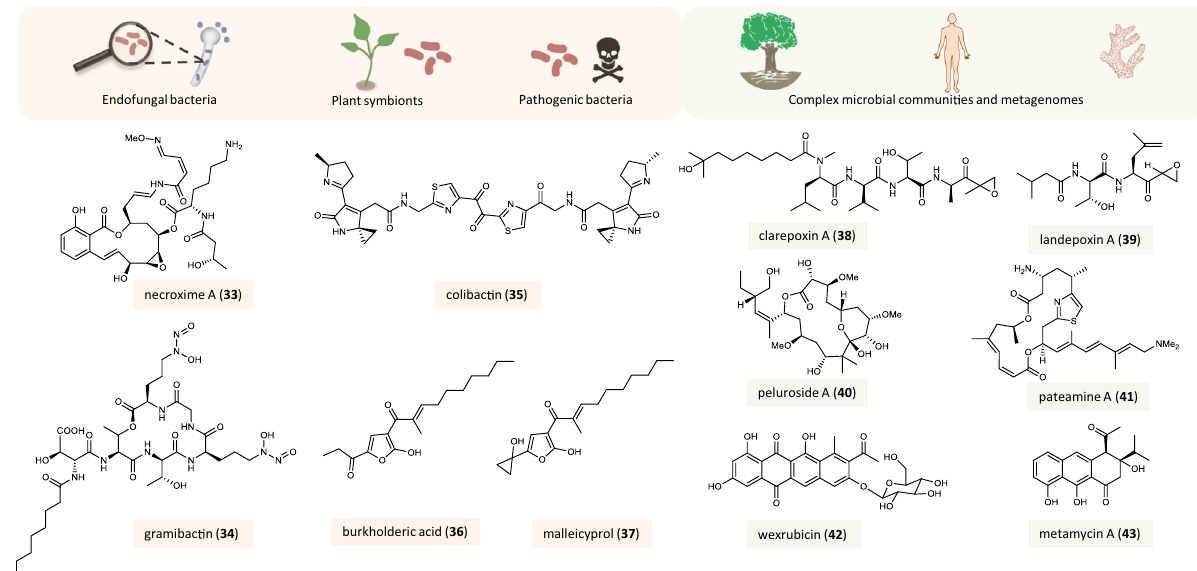
Fig. 5 Genome-guided discovery of natural products from ecological interactions. Symbiotic relationships among few or multiple partners as sources and examples of natural products discovered from these interactions. The color code of the boxes around the compound names and icons indicates the source of the respective compound: light orange — interactions among de fi ned partners (endofungal bacteria, plant symbionts, and pathogenic bacteria), green — interactions among complex microbial communities (plant and human microbiota as well as marine